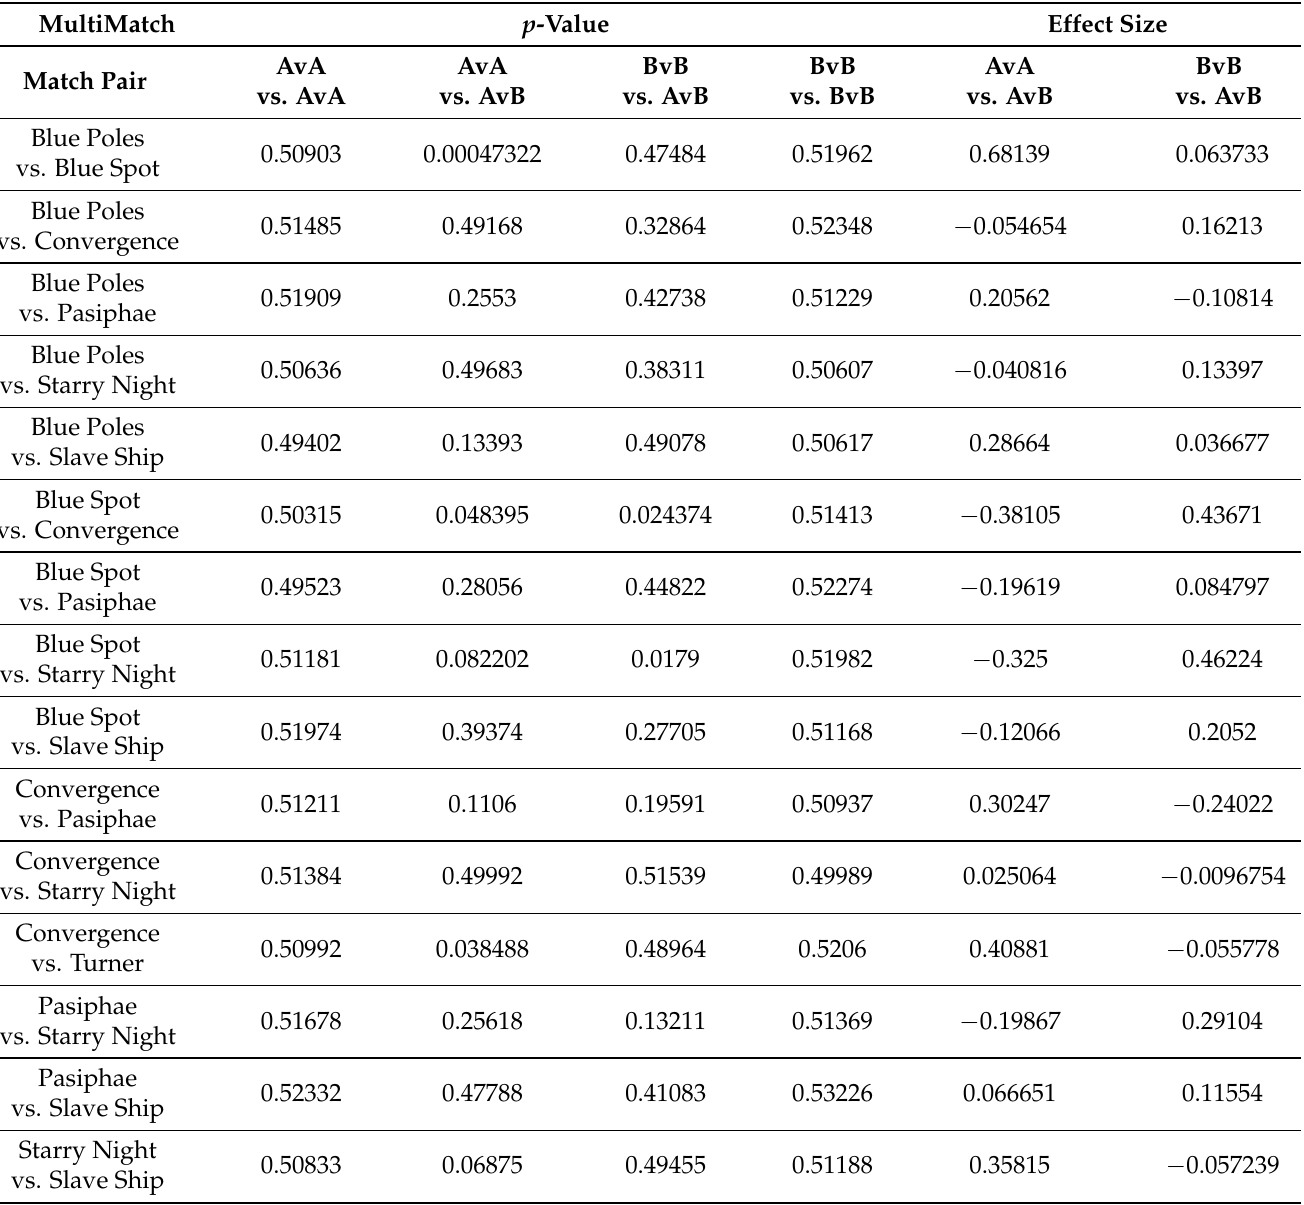
Table A5. MultiMatch length results. Match pair (e.g., Blue Poles vs. Blue Spot), where AvA, AvB, and BvB represents a match score based on a comparison of the one member of the pair with itself, or the first member of the pair ( A ) (e.g., Blue Poles) and the second member, B (e.g., Blue Spot). The effect size for (AvA vs. AvA) and (BvB vs. BvB) in all cases was